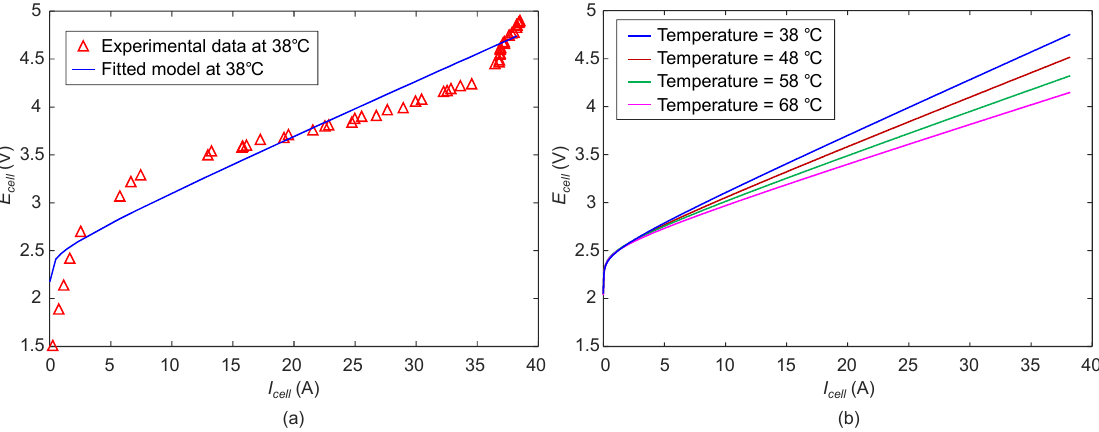
MAPE=4.83% Figure 21. ( a ) Comparison and ( b ) simulation of polarisation curve.